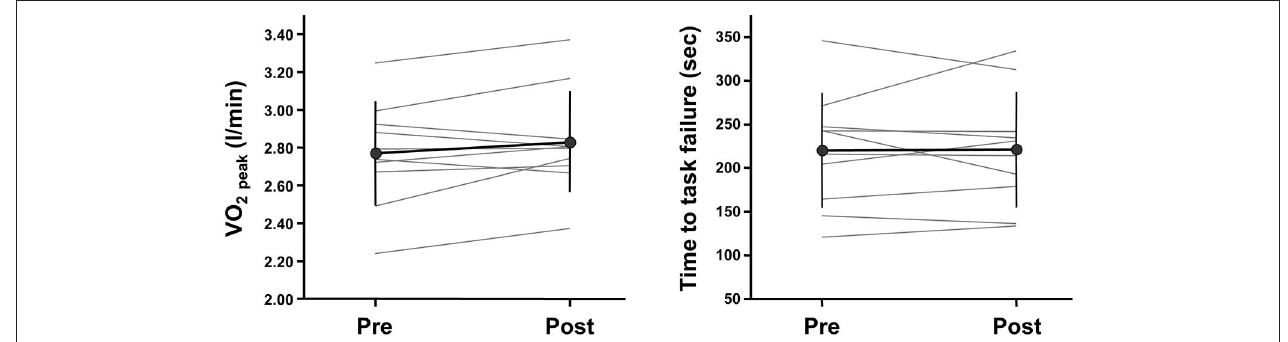
FIGURE 2 | Individual changes in whole-body and local exercise performances before and after a 2-weeks ischemic preconditioning intervention. Whole-body and local exercise performances are assessed with peak oxygen consumption (VO 2 peak ) during a ramp-incremental cycling test and time to task failure during a knee extensor sustained endurance test,